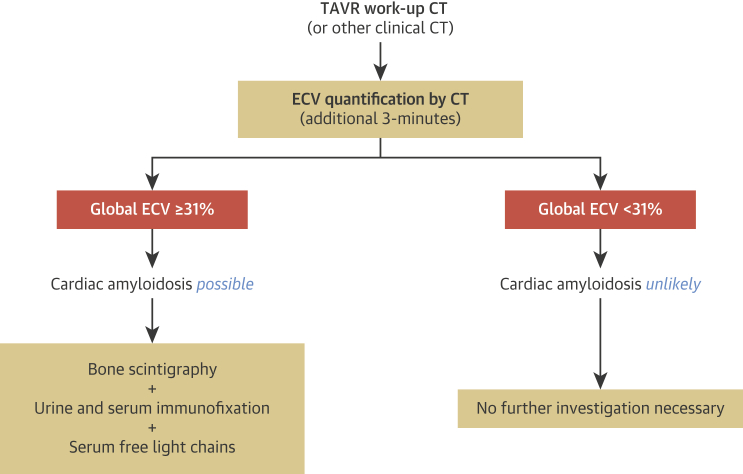
Proposed ECVCT Screening Algorithm for Incorporation Into Routine Clinical WorkflowThe algorithm can be adjusted to an ECVCT threshold of ≥29% for the detection of all grade 1 DPD patients. TAVR = transcatheter aortic valve replacement; other abbreviations as in Figures 1 and 2.